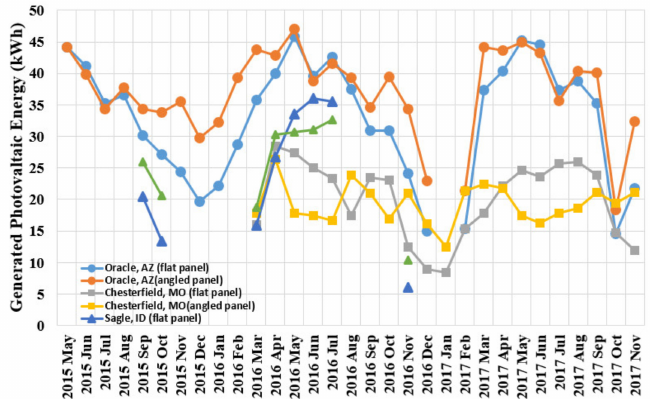
Figure 4. Energy harvesting data for three di ff erent